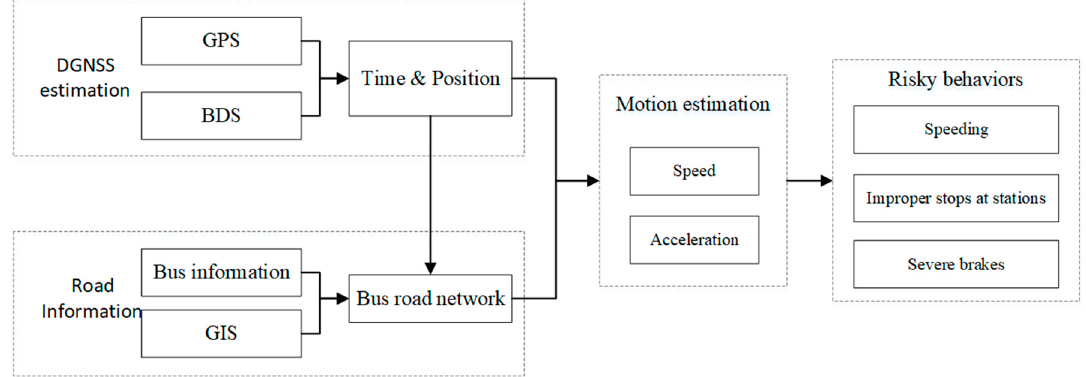
Figure 4. Flow chart of the bus driving statistics and behavior analysis.